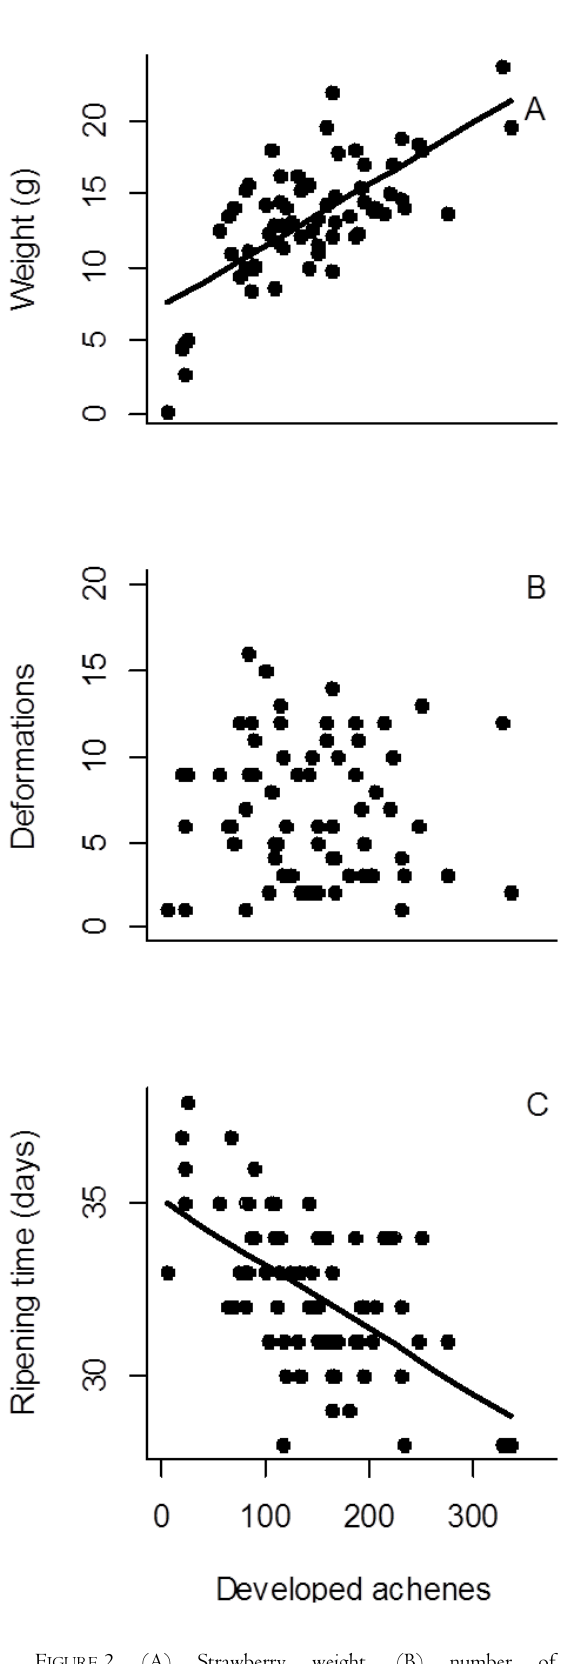
malformations and (C) ripening time in relation to the number of developed achenes. Dots show data on individual strawberries and trend lines are shown if